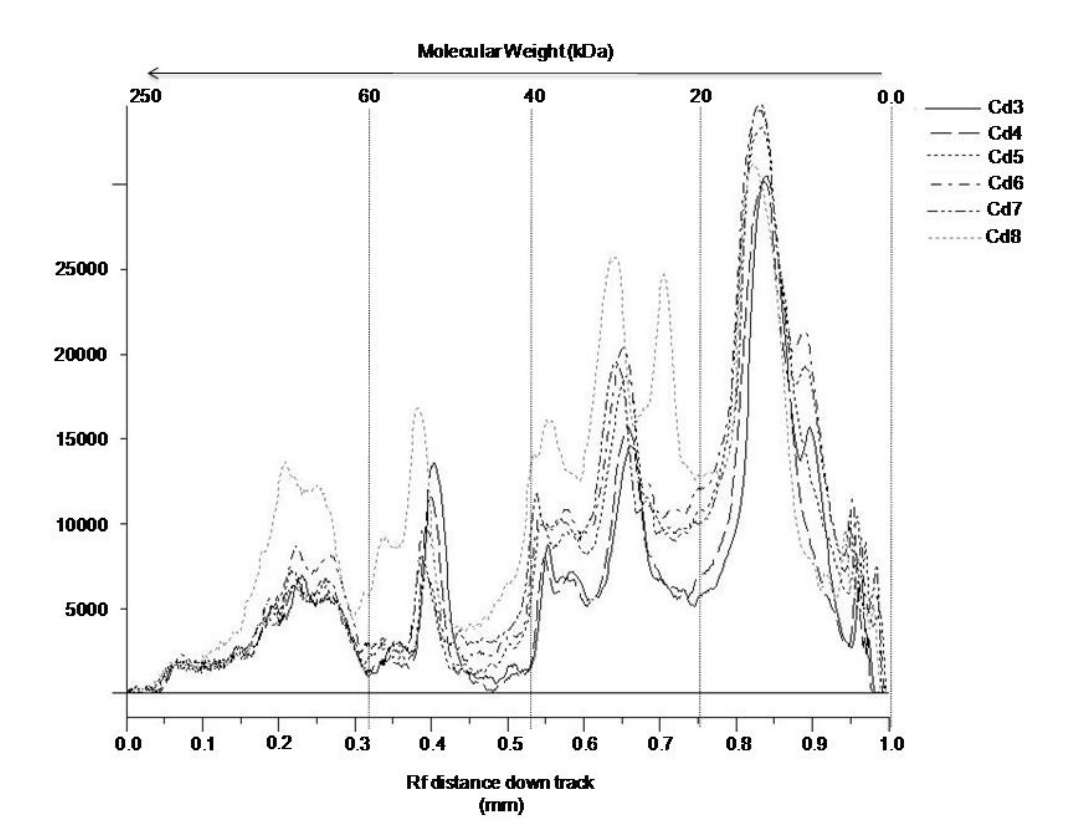
Figure 2. Comparative electrophoretic profiles of venoms from the offspring. The analysis was carried out using the GeneSnap® program after gel documentation. Cd3, Cd6, Cd7 were males and Cd4, Cd5, Cd8 were